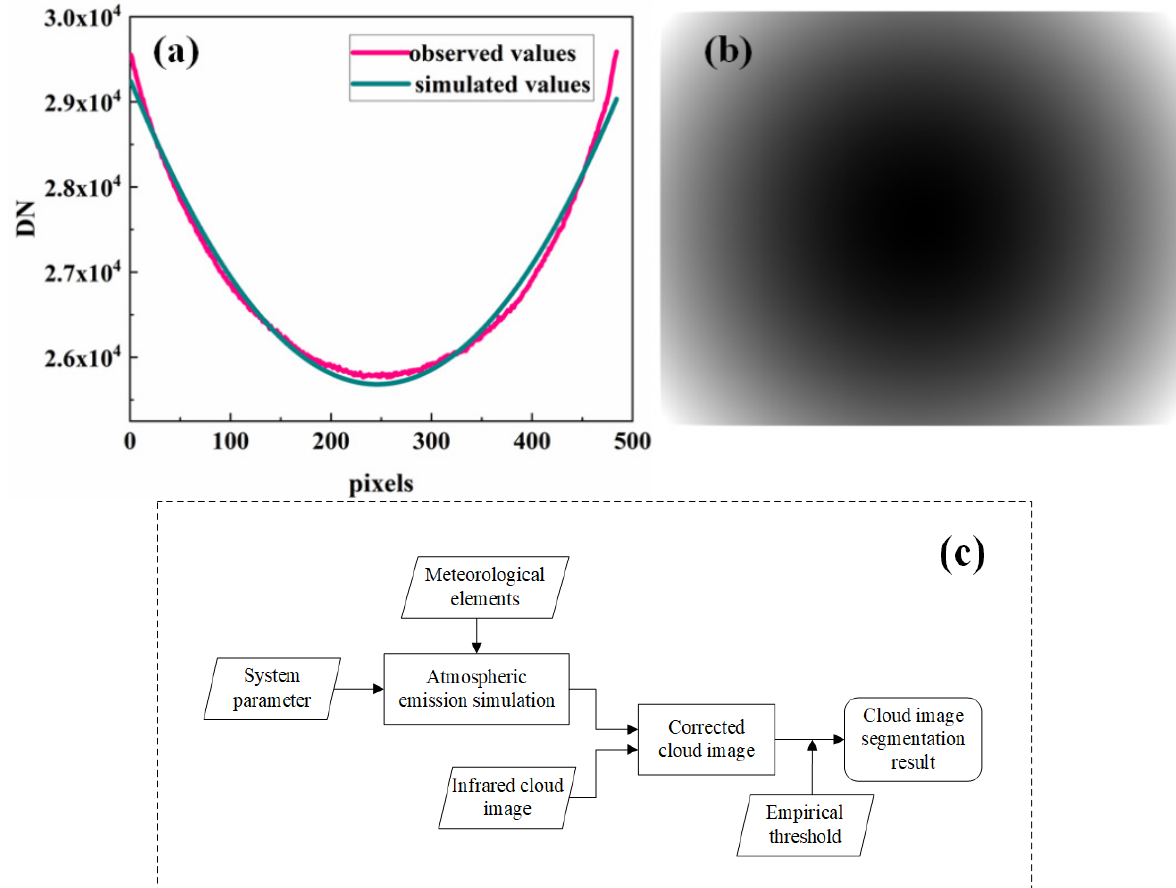
Figure 6. ( a ) Measured and modeled profile of the pixel value of clear sky along one azimuth; ( b ) modeled infrared clear sky image; ( c ) the framework of the proposed method.